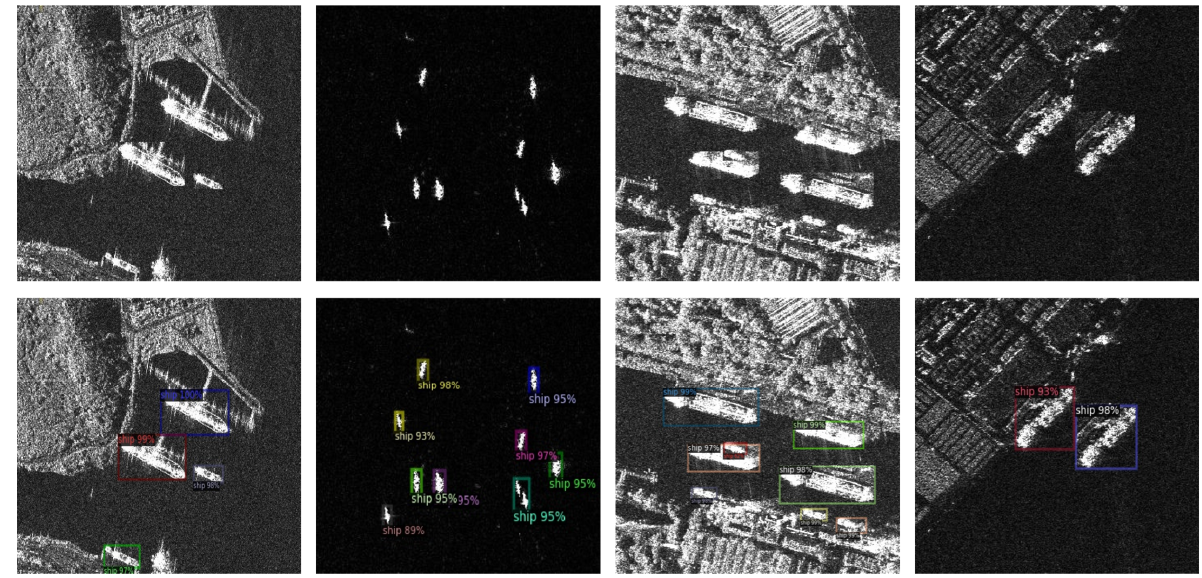
Figure 10. Visualization of results on the ASSDD dataset. The first row is the enhanced image and the second row is the corresponding detection result. Table 6. Comparison of different enhancement strategies.